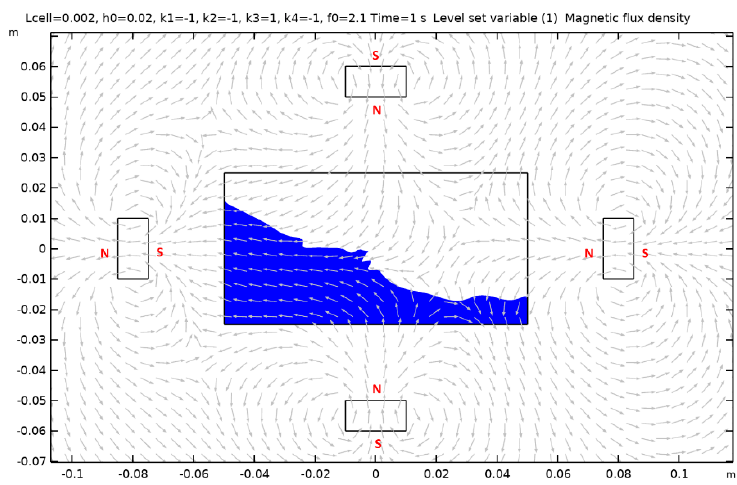
Figure A2. Case 3. Figure A2. Case 3.